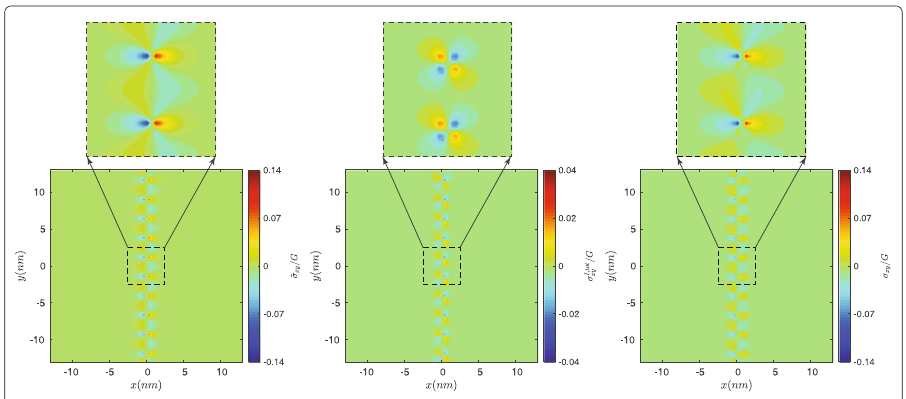
Fig. 9 Contours of the: (left) normalized GB-induced shear stress ˜ σ xy / G , (middle) the H-induced shear stress σ I , tot / G , and (right) the total shear stress σ xy show a zoomed-in view of the dashed box